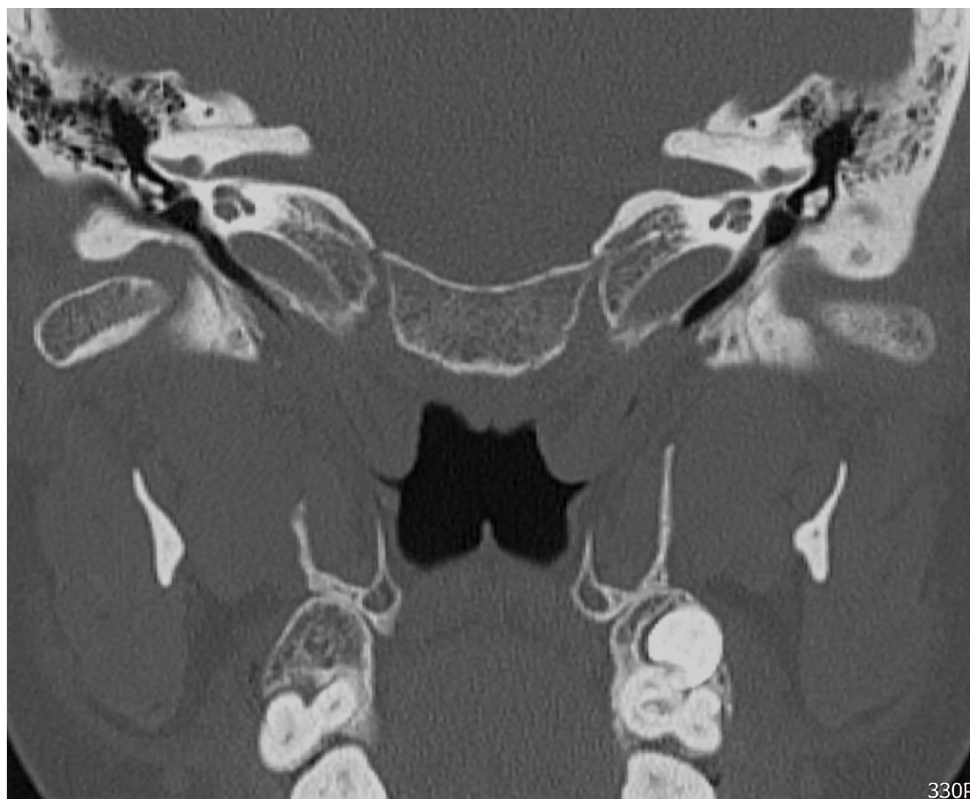
Fig 2. Eustachian tube not visible after Valsalva